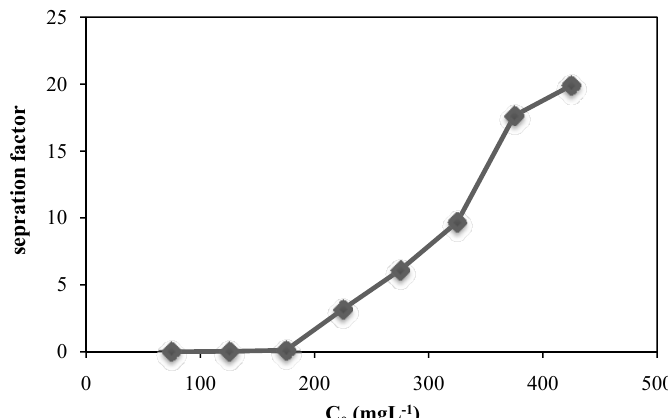
Fig. 11. Separation factor ( 1 2 α ) as a function of total initial concentration with the initial concentration ratio of 1:1 Ca 2+ and Mg 2+ .